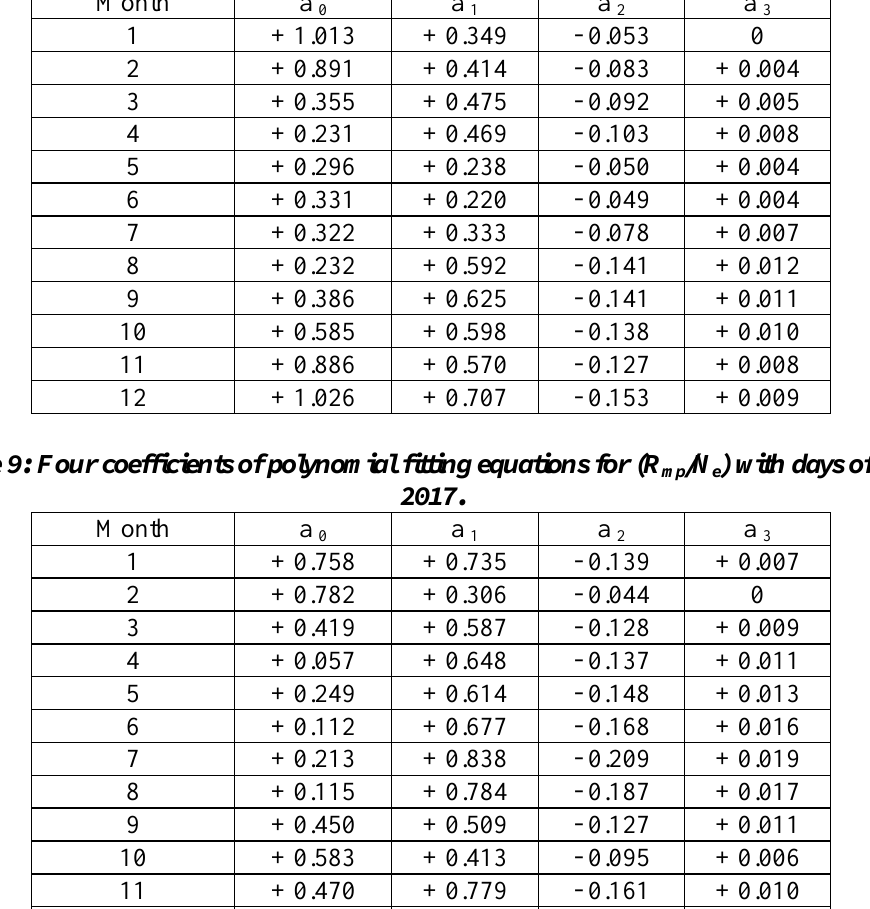
/N ) with days of year mp e